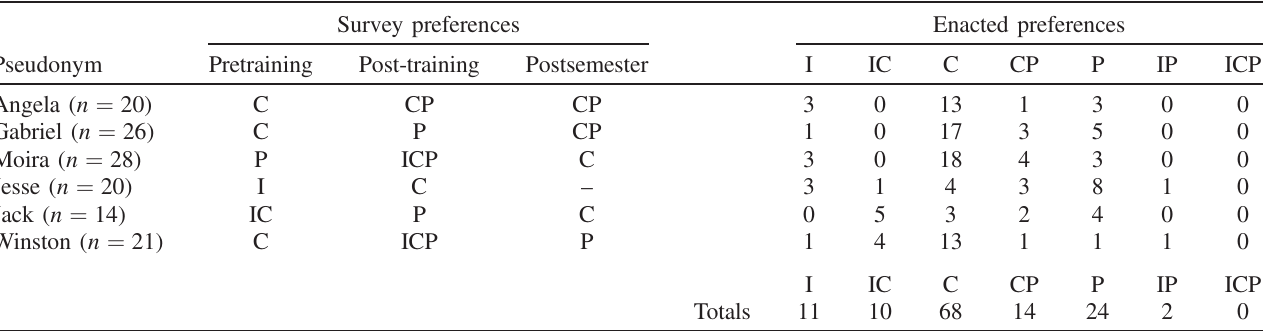
TABLE II. Summary of the stated (surveyed) and enacted preferences of the six UEs who are the focus of this study. The number, n , of pedagogical moments collected and analyzed for each UE is listed. The letters I; C; P denote the instruction, consultation, and participation modes, respectively. Instances of a single letter denote a solo-modal preference. Combinations of one or more letters denote a preference, either stated or observed in enacted pedagogy, for multiple modes. Where shared preferences are reported in the survey, a UE gave either explicit or implicit preference. Where shared preferences are reported in observation, CHAT analysis resulted in an assignment of multiple modes within the same teaching event.